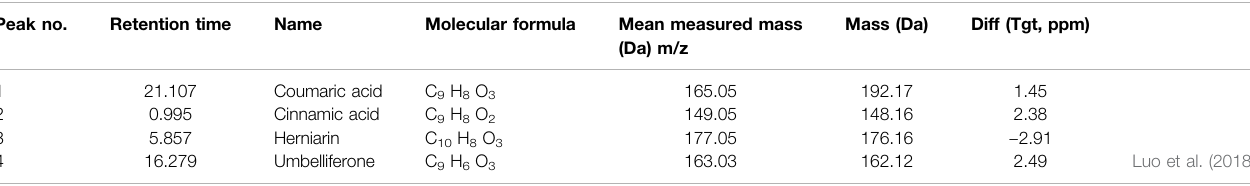
TABLE 2 | QTOF-ESI-MS data of identi fi ed plant metabolites from hydroalcoholic extract of DP in positive mode [M+H] + with possible molecular formula. Peak no.